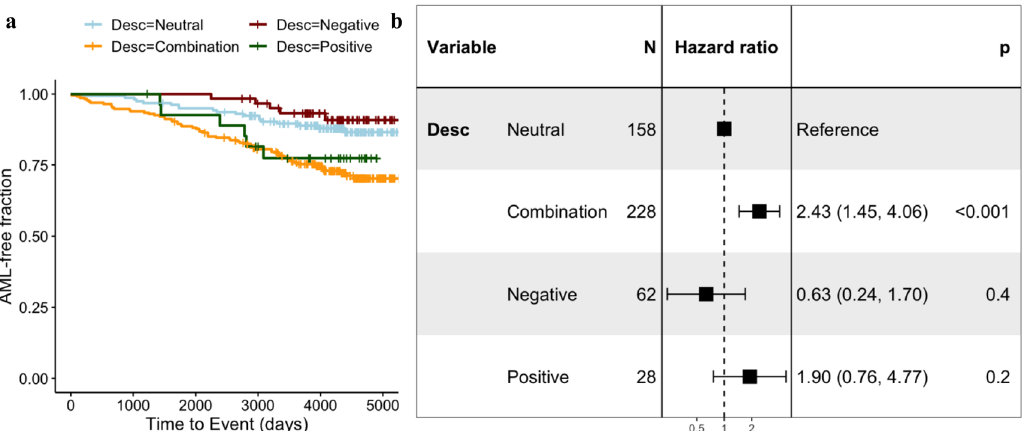
Fig. 4 Negative selection is associated with AML-free survival. a Kaplan – Meier curves of AML-free survival among EPIC participants. Survival is de fi ned as the time between blood sample collection and diagnosis (for cases), for control survival is right-censored at last follow-up. Survival curves are strati fi ed according to evolutionary class (positive = green, negative = red, combination = orange, neutral = blue). b Forest Plot of risk of AML development across evolutionary classes. Each row indicates hazard ratios associated with each evolutionary class (reference = neutral class). The horizontal lines indicate a 95% con fi dence interval for each